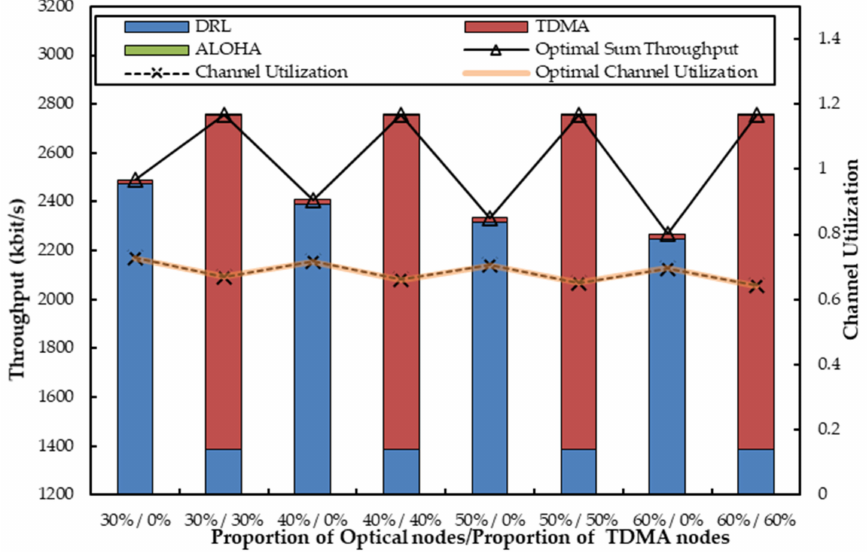
Figure 11. Network performances of different proportions of optical nodes and TDMA nodes. (1.) Short-term Sum Throughput: Figure 12 exhibits the throughput of OA-DLMA, O-DLMA, OA-CMAC, and UMC-DLMA protocols with different values of q ( q = 0, 0.3, 0.5, and 0.7). Regardless of q value, the throughputs of the three DRL-based protocols (OA-DLMA, O-DLMA, and UMC-DLMA) far outweigh those of the OA-CMAC